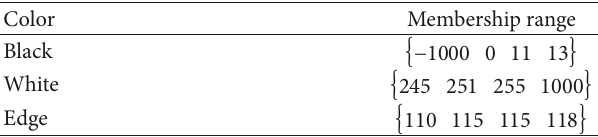
Table 4: Final output membership functions.